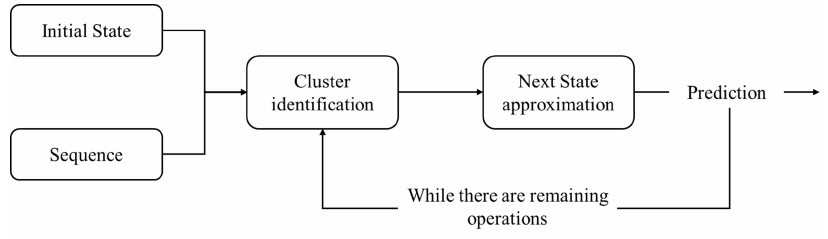
Figure 11. Prediction process for the dictionary model.